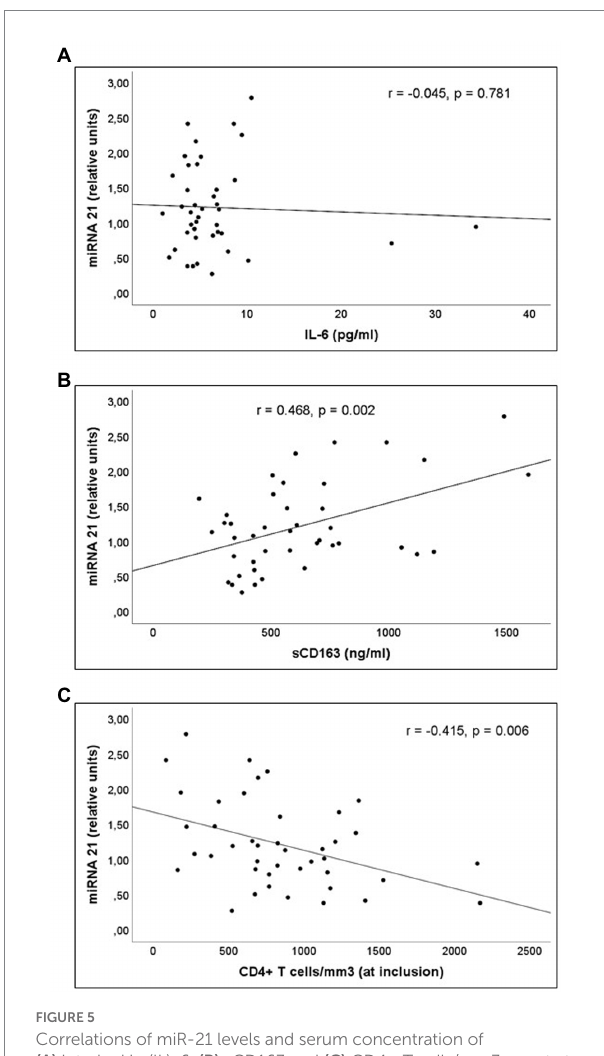
FIGURE 5 Correlations of miR-21 levels and serum concentration of (A) interleukin (IL)-6, (B) sCD163 and (C) CD4+ T cells/mm3 count at inclusion, in Group 2 patients (PLWH with prolonged undetectable viral